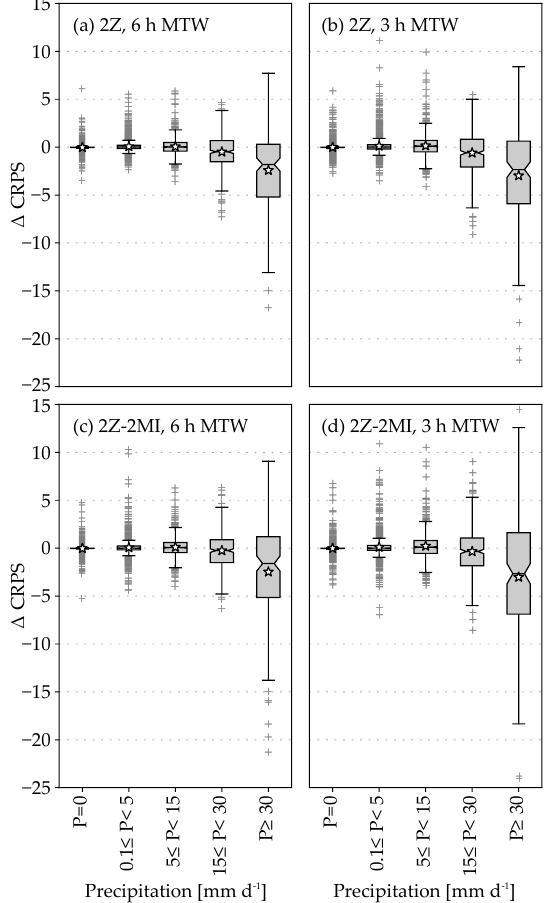
Figure 11. Differences in the CRPS values at the Ulrichen station due to the introduction of the MTW as a function of different daily precipitation thresholds for the target date. The results are provided for the 2Z method (top) and the 2Z-2MI method (bottom) with a 6h MTW (left) and a 3h MTW (right). Stars represent averages. Lower CRPS values indicate better